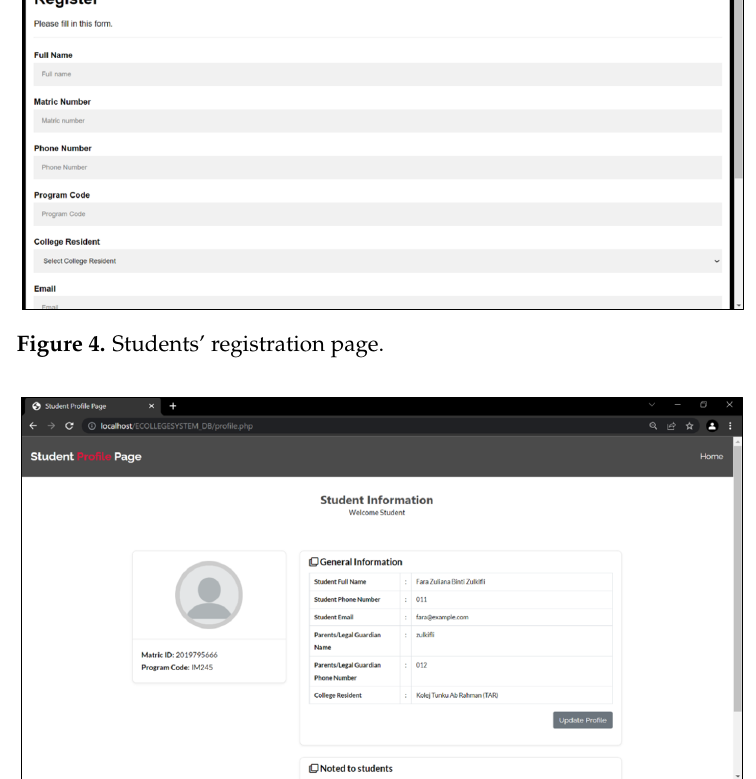
Figure 5. Profile page.